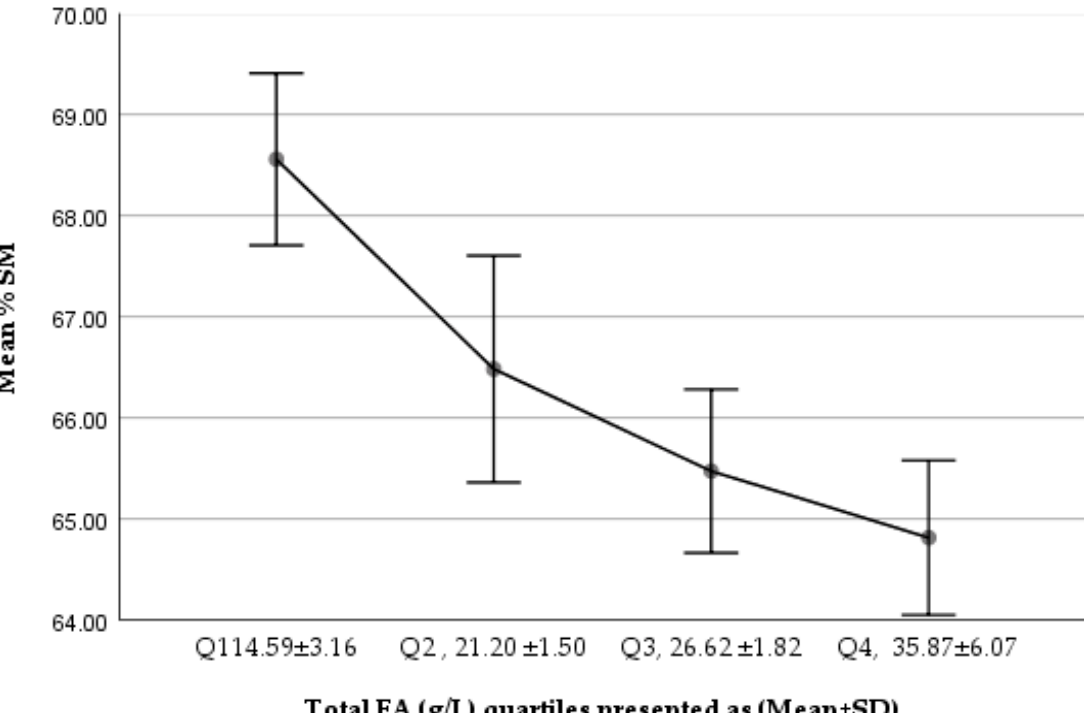
Figure 2. Trend of %SM of total PLs in Q1–Q4 (total FA g/L) of the studied milk samples.